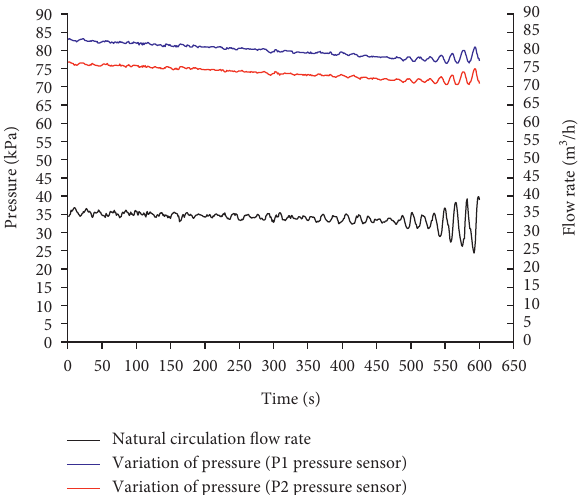
Figure 13: Fluctuation pressure is changing unstably with water level decreases.